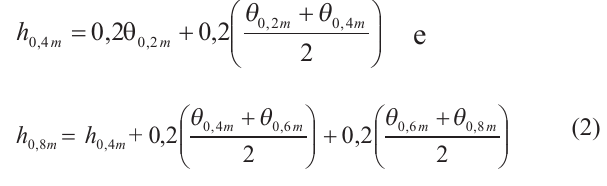
representado por cotas altimétricas relativas à maior cota. Fonte: Brito